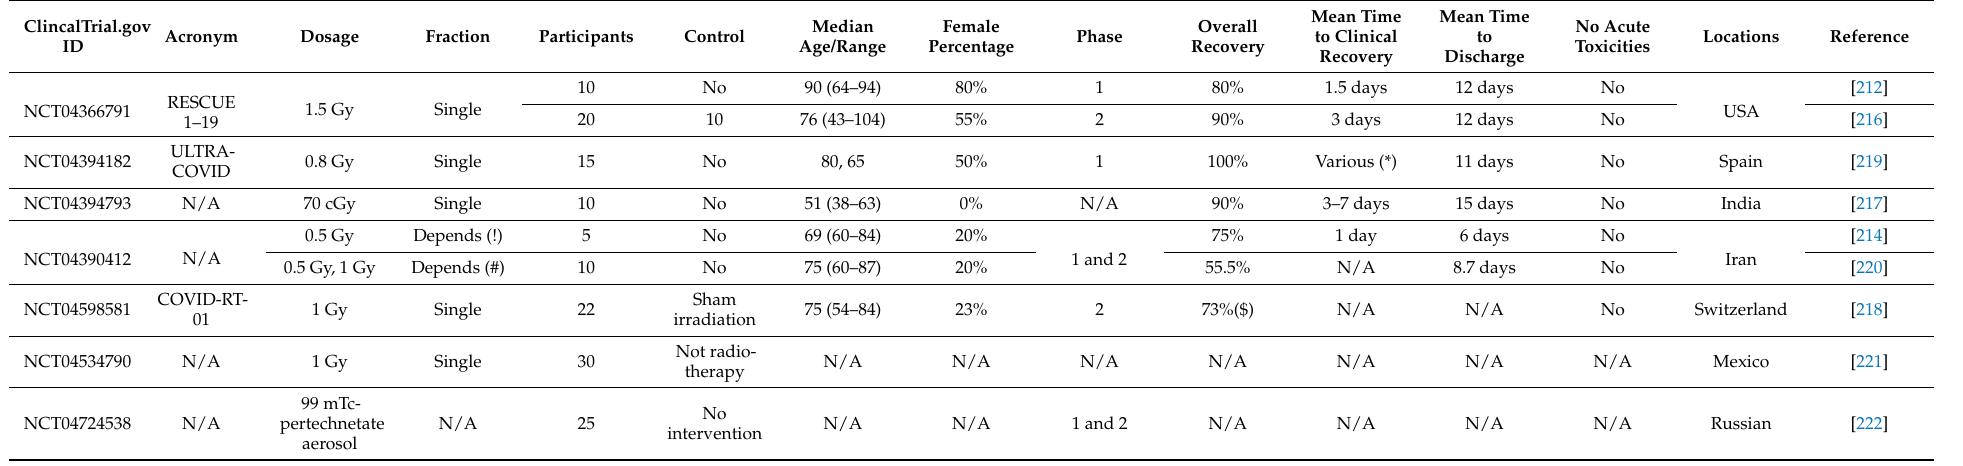
Table 2. Summary of Completed Clinical Trials Using Radiation in the Treatment of COVID-19.